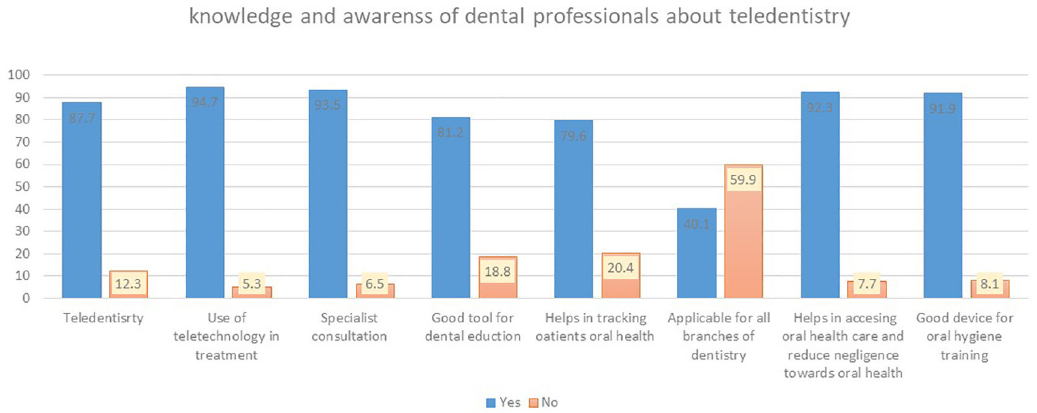
Figure 1. Knowledge and awareness of dental professionals about teledentistry.